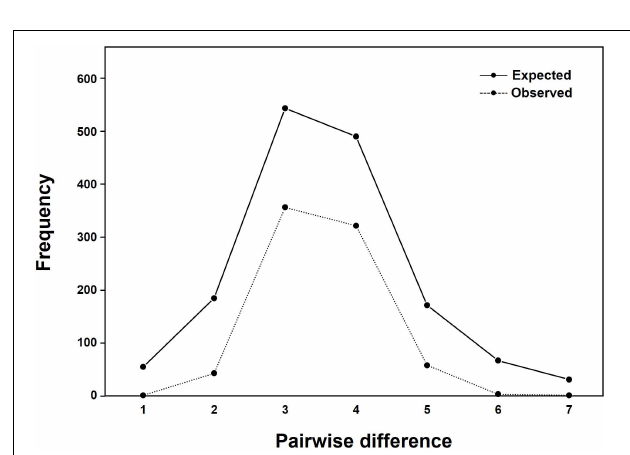
FIGURE 7 | Results of mismatch distribution of nucleotide differences between pairs of mtDNA COI and 16S haplotypes (1,304 bp) in Dissostichus mawsoni . There was a significant difference between the observed and expected frequencies (sum of squared deviation = 0.1148, P =